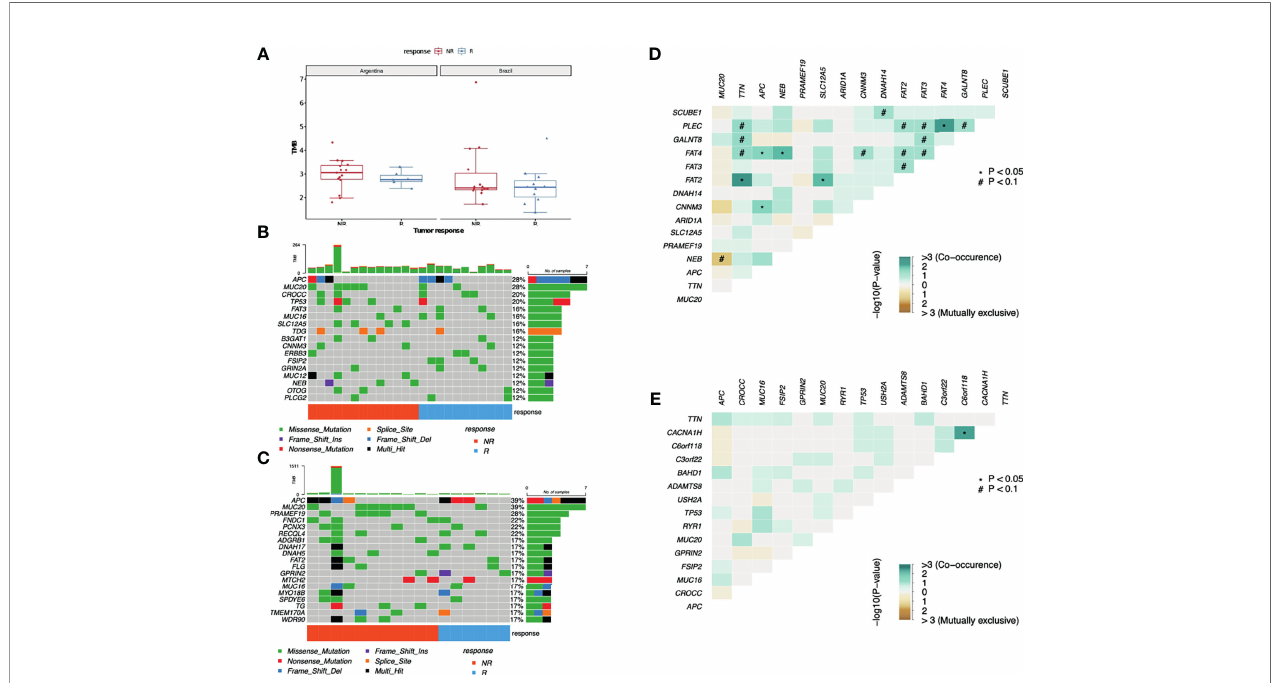
FIGURE 1 | Mutational pro fi le from LARC samples. (A) TMB comparison between AR and BR pre-treatment biopsy samples from R and NR patients diagnosed with LARC (Wilcoxon test p- value = 0.4 for AR R vs. NR; p -value = 0.58 for BR R vs. NR). (B) Distribution of somatic mutations found in pre-treatment biopsies of LARC in BR and (C) AR samples. Each column represents a patient, and each line represents a gene. The upper plot shows the number of mutations (TMB) in each sample, the central plot shows the mutation types as indicated by the colors, the right plot indicates the number of samples with mutations in that speci fi c gene, and the lower part of the fi gure indicates the response of each patient (R, responder; NR, non-responder). (D) Co-occurrence of genetic alteration analysis in LARC biopsies before neoadjuvant treatment obtained from NR and (E) R